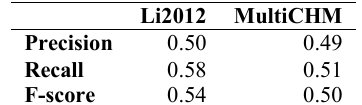
Table 3. Volume values (m 3 /ha) and differences.